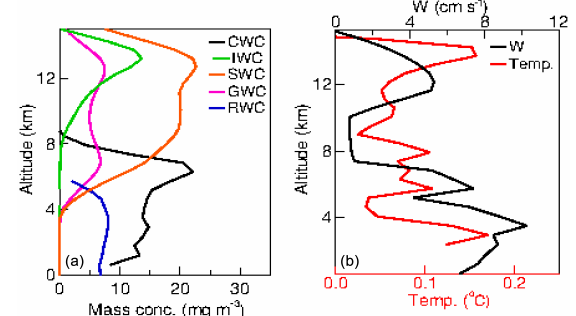
Figure 8. (a) Simulated difference (Ex3–Ex1) in mean profiles of cloud water content, rain water content, ice water content, graupel water content, and snow water content. (b) CCN-induced difference (Ex3–Ex1) in simulated mean profiles of vertical velocity (black) and temperature (red) for cloudy